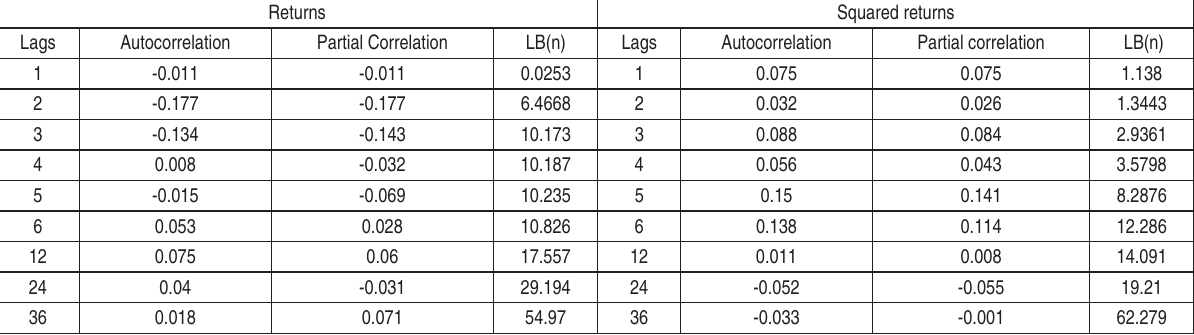
Table 2. Test for serial dependence in the first and second moments of CSI series